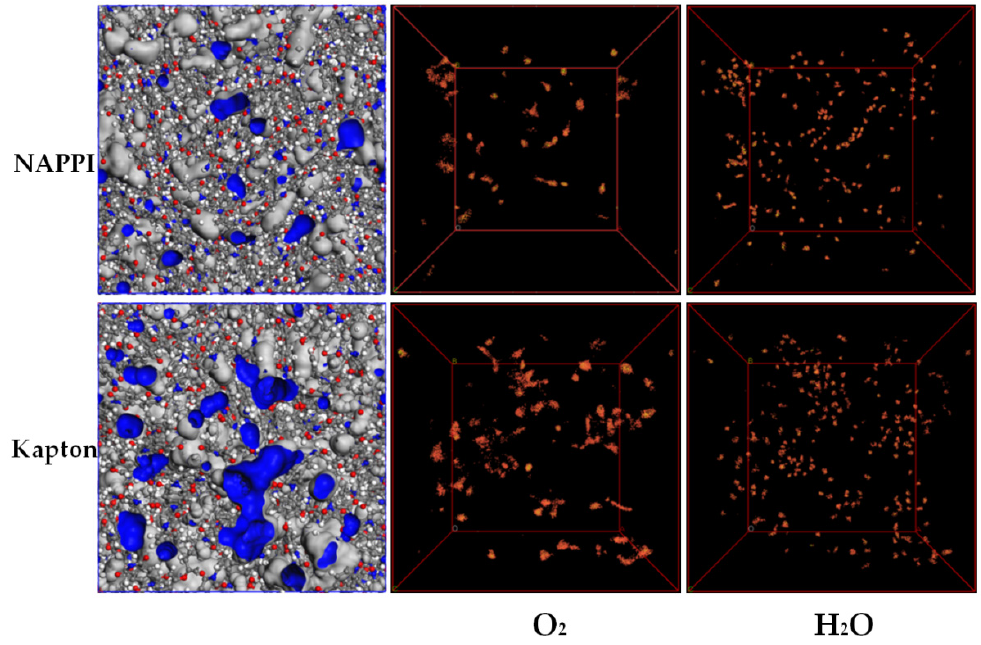
Table 5. Solubility coefficients, diffusion coefficients and permeability coefficients for H 2 O and O 2 in NAPPI and Kapton.